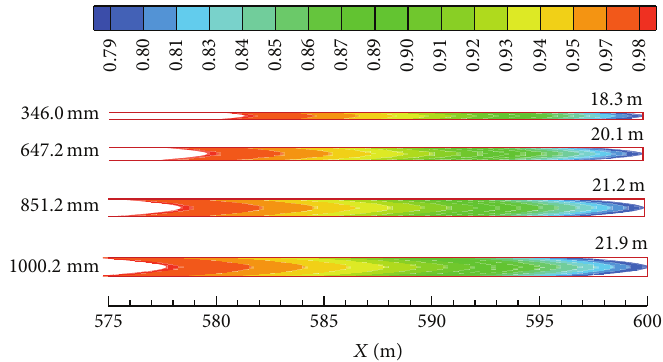
Figure 7: The maximum gas mixture length for different pipe diameters.